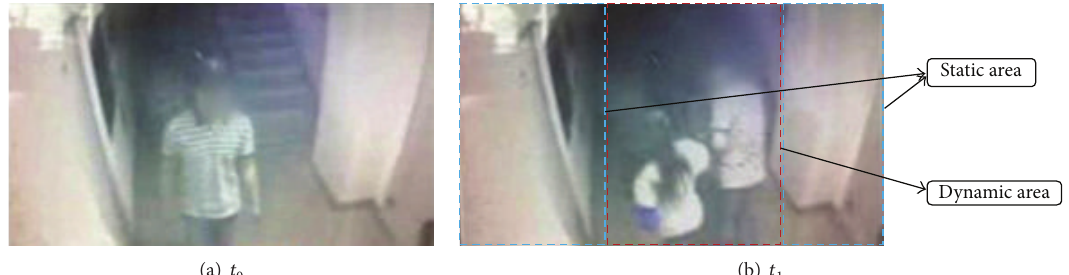
Figure 2: Characteristic of sensed images in the wireless multimedia sensor networks.